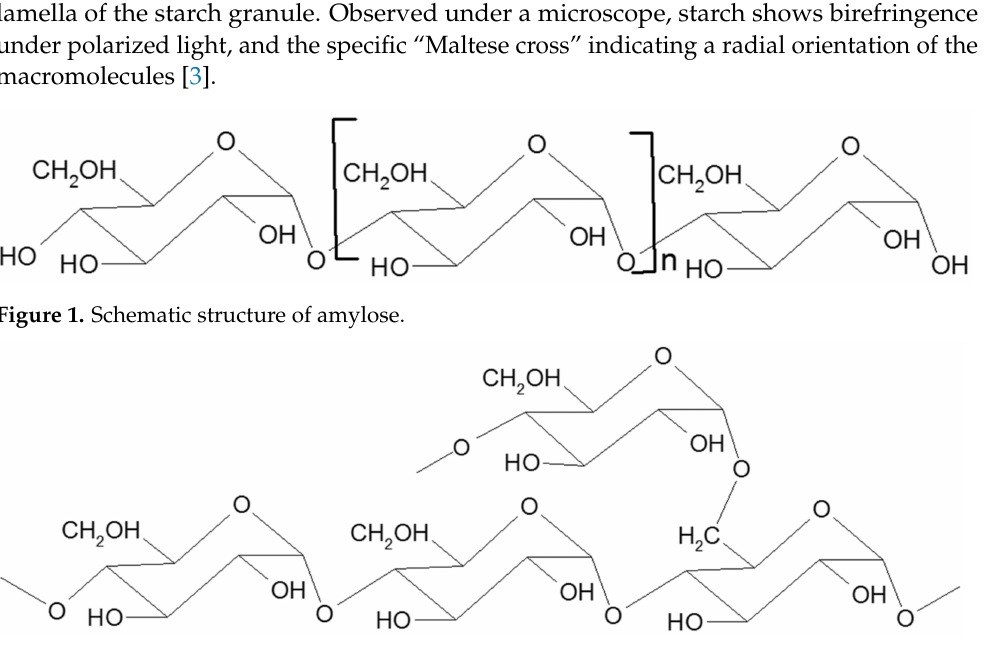
Figure 2. Schematic structure of